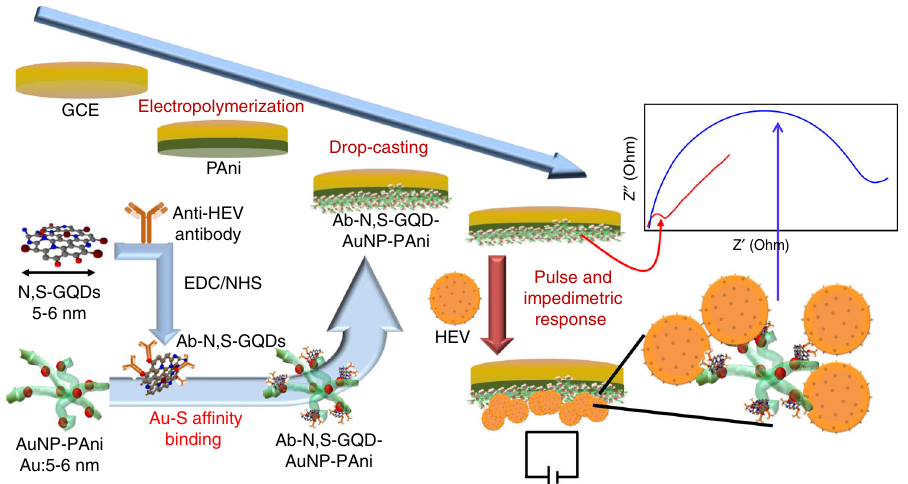
Fig. 1 Schematic diagram of the Ab-N,S-GQDs@AuNP-PAni nanocomposite-loaded sensor electrode and its pulse-induced impedimetric sensing